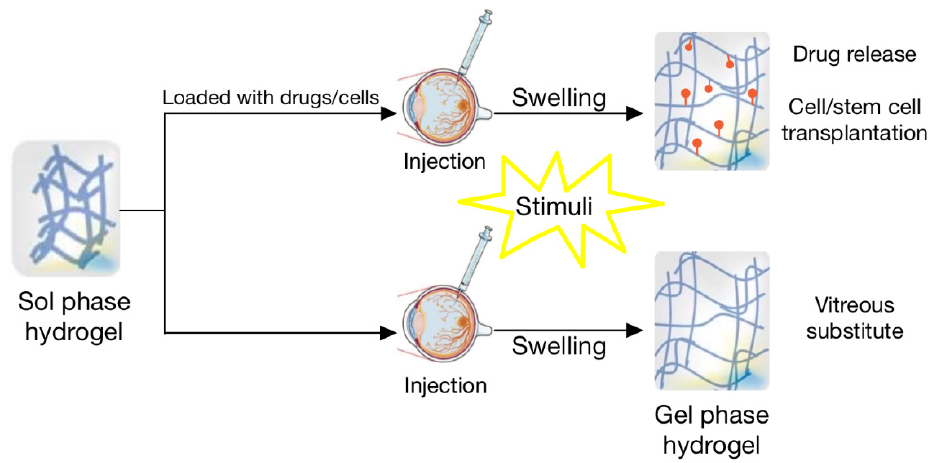
Figure 2. Sol phase hydrogel is liquid and injectable. A chemical or physical change after admin- istration to the eye acts as a stimulus that causes the transition to the gel phase. The hydrogel swells and can serve as a drug-eluting mechanism, cellular scaffold, or vitreous substitute. Adapted with permission from ref. [47]. Copyright 2020 Royal Society of Chemistry and Reprinted with permission from ref. [48]. Copyright 2015 Creative Commons Corporation (this figure is a derivative of “Figure 2” by Fathi et al. (2015) used under CC BY-NC 4.0)